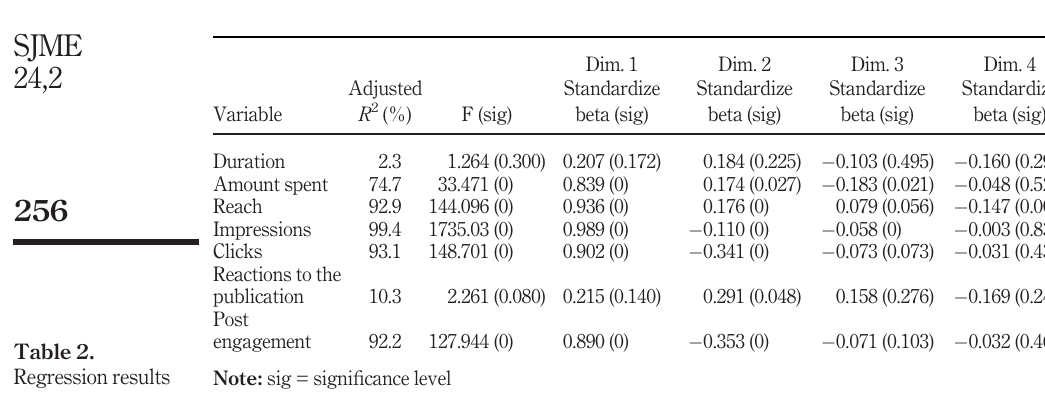
Table 2. Regression